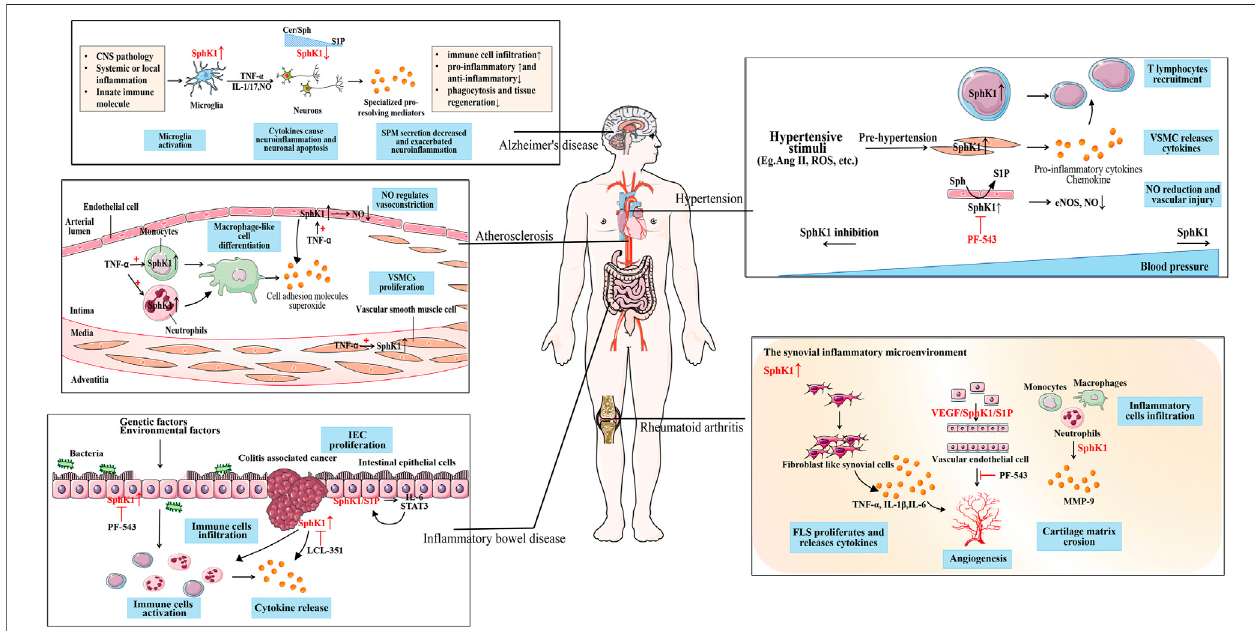
FIGURE 2 | The role of SphK1 in in fl ammation immune-related diseases. SphK1 is over-expressed in a variety of in fl ammation immune-related diseases. Hypertension caused by the production of cytokines and various stimuli is accompanied by the activation of the immune system. In the in fl ammatory environment, the up-regulated SphK1 isinvolved in therecruitmentof Tlymphocytesto thein fl ammatory site, the release ofin fl ammatorycytokines, and the vascular injury causedby the reduction of NO release in the pathogenesis of hypertension. As SphK1 is abnormally activated, SphK1 inhibition (such as PF-543) can effectively reduce blood pressure. Atherosclerosis is accompanied by the activation of the immune system. SphK1 activated by TNF- α promotes the differentiation of macrophage-like cells in immune cells, produces cell adhesion molecules and superoxide, and the proliferation of VSMCs. SphK1 over-expressed in ECs regulates the release of NO for vasoconstriction,whichisthecauseofvascularin fl ammation.SphK1isover-expressed inactivated microglia, promotes thereleaseofpro-in fl ammatorymediators,and causesneuroin fl ammationandneuronalapoptosisinAD.WhereasSPMreductionisassociatedwithdown-regulatedSphK1inneurons,aggravatingneuroin fl ammation which may be due to sphingolipid-rheostat modulation. SphK1 over-expression activates immune cells to release cytokines in the IEC of IBD caused by genetic and environmental factors. When developing into CAC, SphK1 induces the expression of pro-in fl ammatory markers and immune cell in fi ltration, which can be alleviated by SphK1 inhibition (such as LCL351). SphK1/S1P forms a positive feedback with downstream IL-6/STAT3 to maintain the proliferation of IEC. SphK1 is abnormally over- expressed in the synovitis microenvironment of RA, participates in FLS proliferation, the release of in fl ammatory cytokines, and in fl ammatory cell in fi ltration. Over- expression of SphK1 mediates the proliferation of ECs and forms neovascularization, which may be related to VEGF/SphK1/S1P signal. SphK1 inhibition (such as PF- 543) can improve synovial microvascular